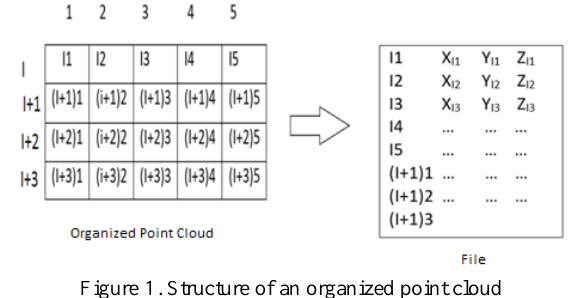
Figure 1. Structure of an organized point cloud By contrast, in an unorganized point cloud t he records in its file